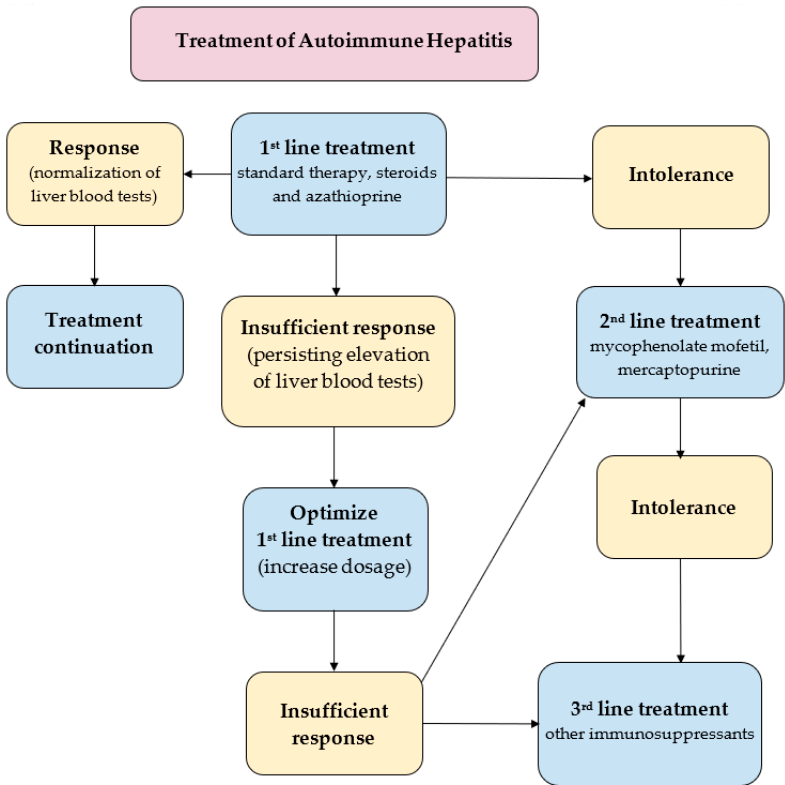
Figure 3. Treatment strategies in AIH [113,114,125,127].